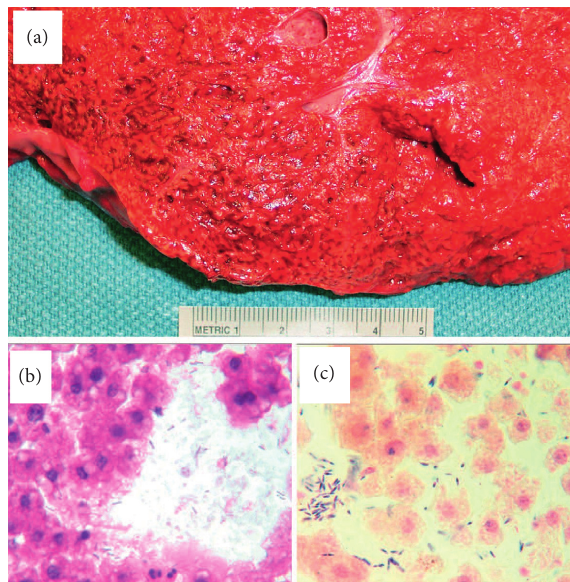
Figure 1: (a) Liver parenchyma at autopsy. (b) H&E stained section of the involved liver tissue (600x magnification). (c) Gram stain section of the involved liver tissue illustrating spore-forming Gram-negative rods (600x